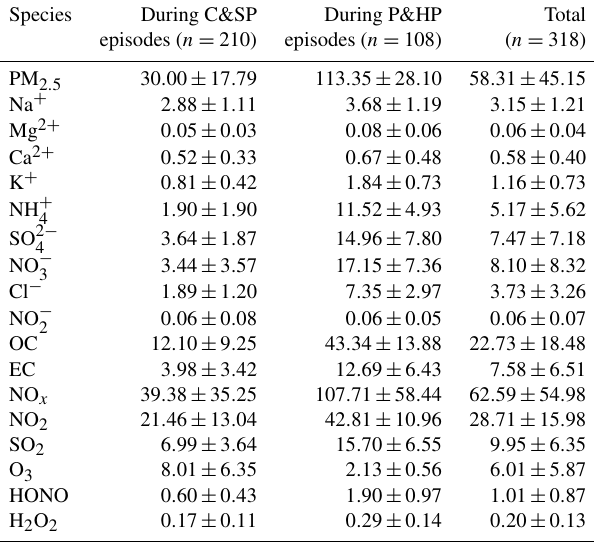
Table 1. The average concentrations of the species in PM 2 . 5 (in mi- crograms per cubic meter) and typical gaseous pollutants (in parts per billion) during C&SP episodes (PM 2 . 5 < 75µgm − 3 ), during P&HP episodes (PM 2 . 5 ≥ 75µgm − 3 ) and during the whole sam- pling period.